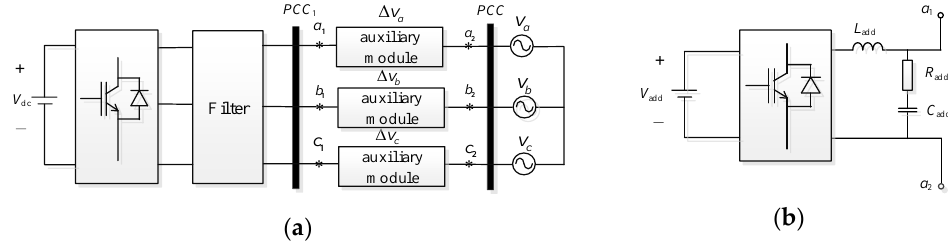
Figure 3. Structure block diagram of the modified topology of grid-connected inverter: ( a ) general system diagram. ( b ) Auxiliary module block diagram.